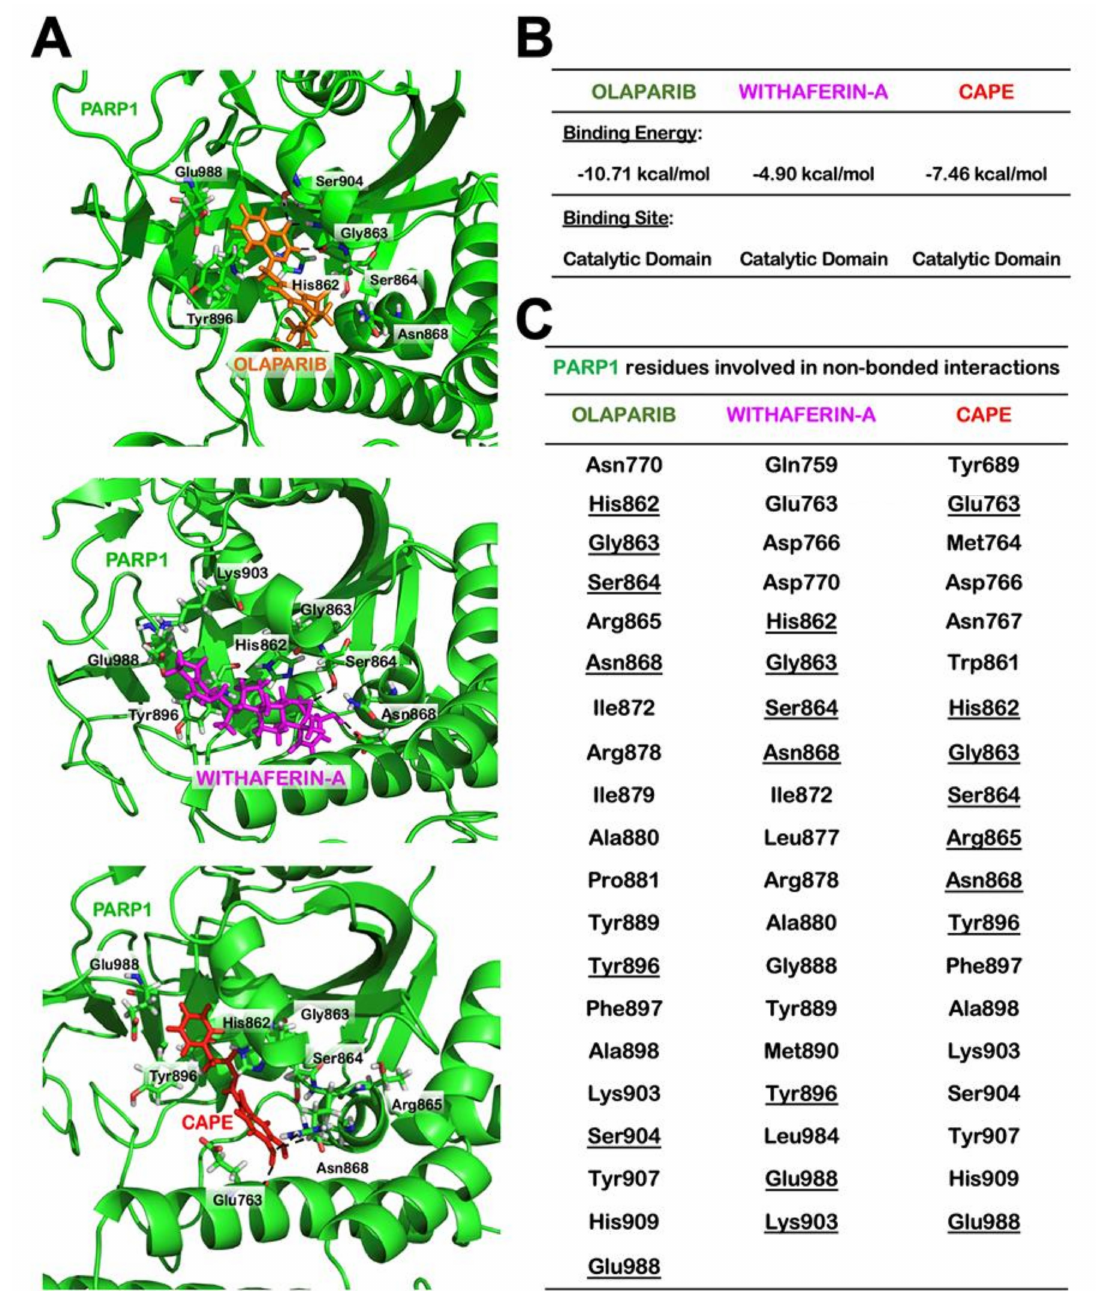
Figure 7. Molecular docking showing interactions of Withaferin A (Wi-A), ca ff eic acid phenethyl ester (CAPE), and Olaparib with poly ADP-ribose polymerase1 (PARP1). Wi-A and CAPE docked to PARP1 at the cavity lined by the catalytically active residues of PARP1, which was similar to the binding of Olaparib to PARP1 ( A ). Calculated binding energies and ( B ) details of PARP1 residues involved in non-bonded interactions ( C